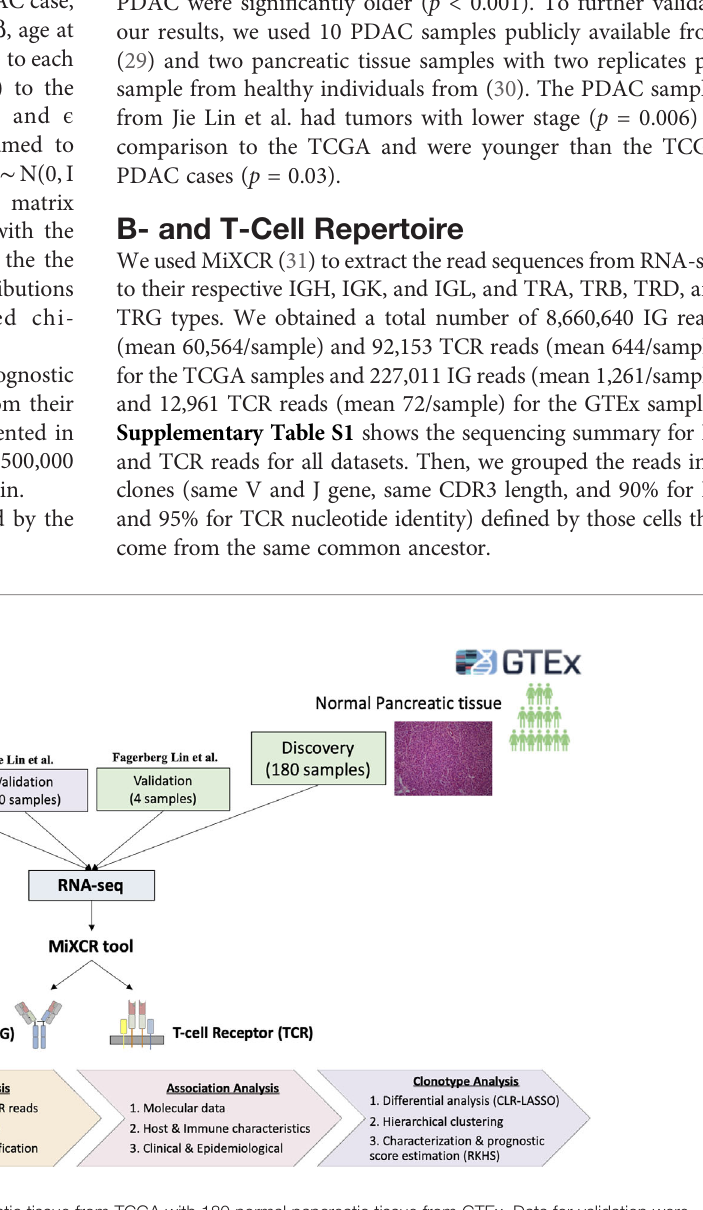
FIGURE 1 | Overall study pipeline. Comparison of 144 tumor pancreatic tissue from TCGA with 180 normal pancreatic tissue from GTEx. Data for validation were considered from Jin et al. (29) with 10 PDAC samples and Fagerberg Lin et al. (30) with two replicated from two normal samples. We used the MiXCR tool to extract IG and TCR from RNA sequencing data and then performed a detailed statistical study to characterize properly the tumor-in fi ltrating immune repertoire by applying diversity, network, association, and clonotype